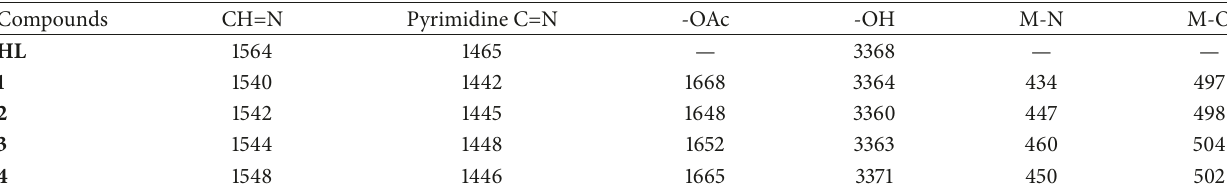
Table 3: Infrared spectral data of the ligand HL and complexes 1 – 4 (cm −1 ).